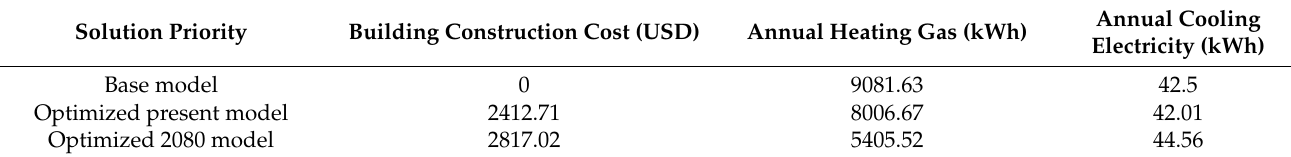
Table 8. Selected optimized measures for the present and future weather